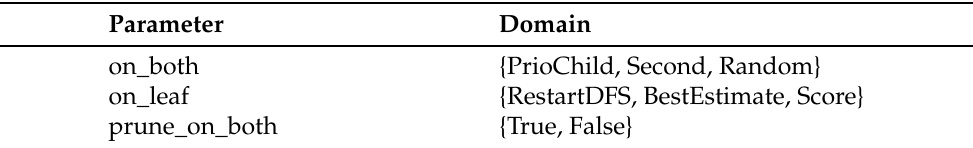
Table 2. Parameter settings for our node selection and pruning policy. Policies are denoted by ML_ followed by up to three letters: ML_{on_both}{on_leaf}{prune_on_both} . Table 4 enumerates the resulting policies.